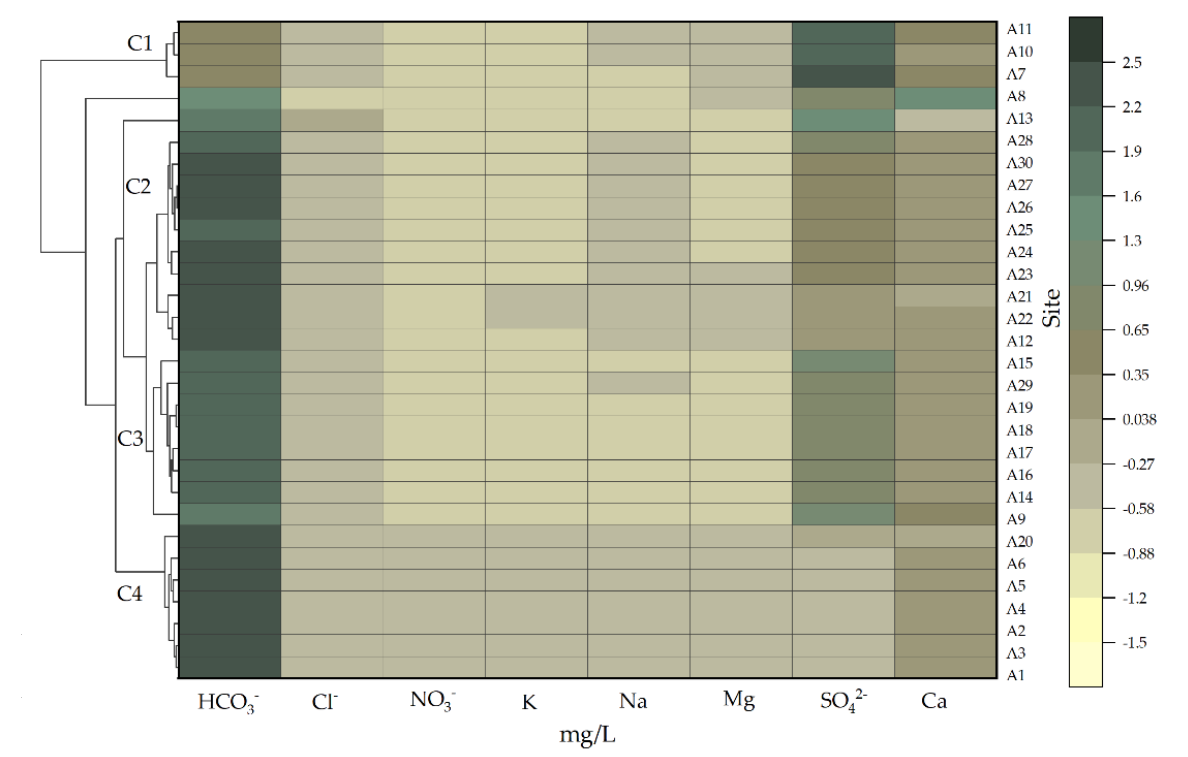
Figure 4. The logarithmic distribution of chemical parameters concentrations (HCO 3 − , Cl − , NO 3 − , K, Na, Mg, SO 42 − , Ca) among the sampling points with the corresponding dendrograms.